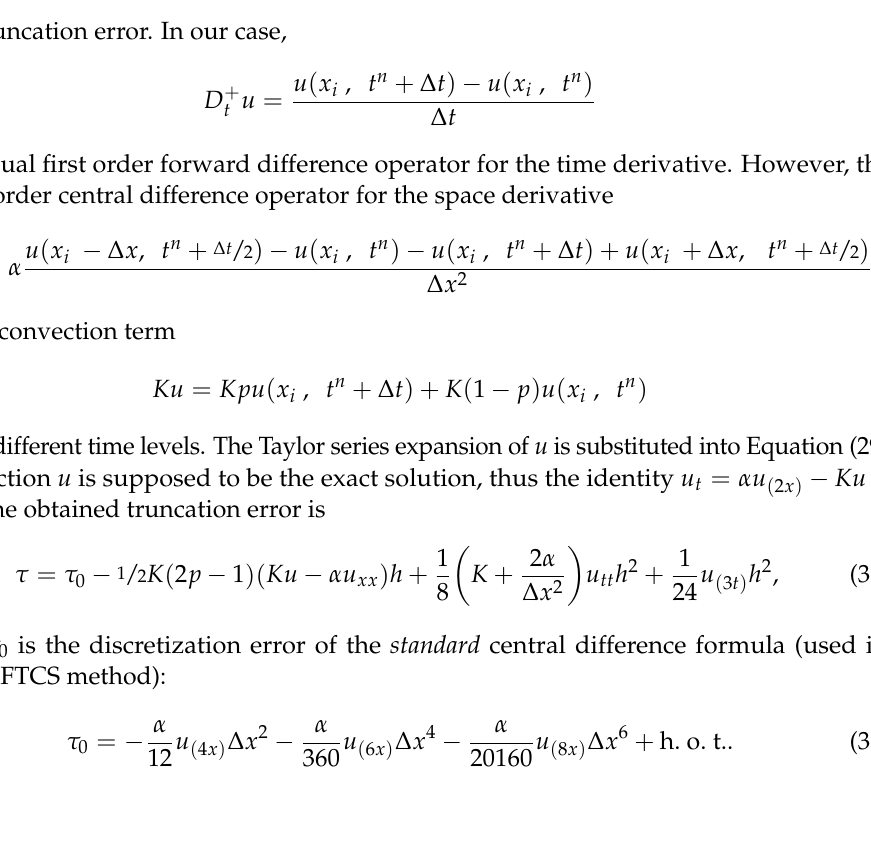
Figure 5. The temperature u as a function of the x variable in the case of the initial function u 0 , the reference solution at t fin , and the LH method for h = 2 · 10 − 3 when the convection term is inside the numerator, and when it is implemented in a mixed